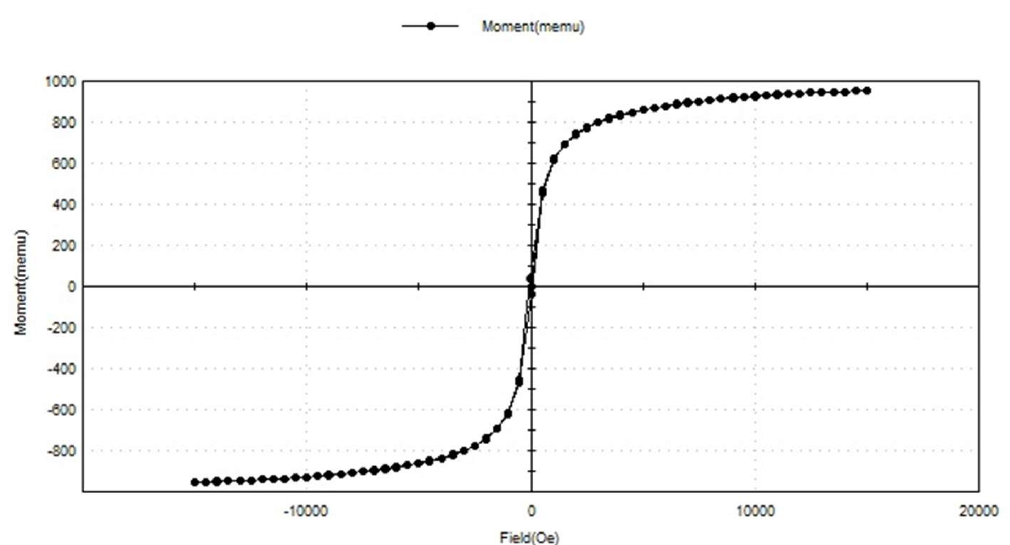
Figure 6. VSM analysis of SPIONs.